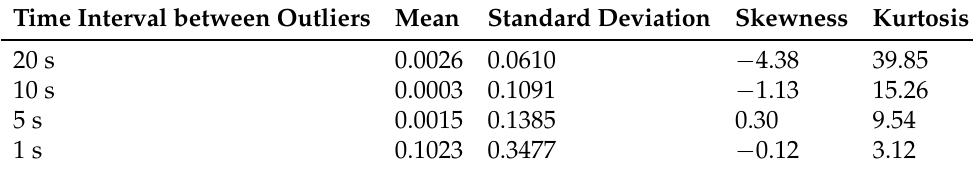
Table 3. Statistical Measures of plant identification error using the MCC criterion.